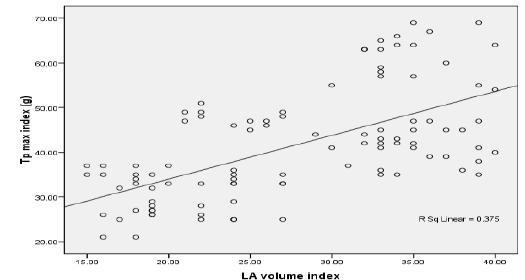
(Figure 1) : correlation between LV dyssynchrony ( T-P max) and LA volume index